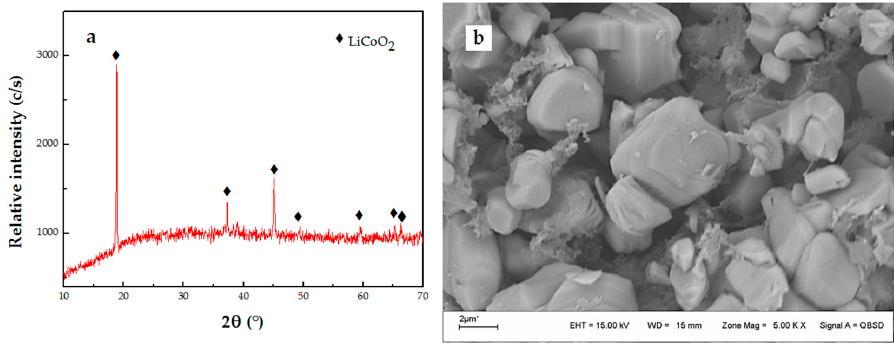
Figure 1. ( a ) XRD and ( b ) SEM of LiCoO 2 from cathodes of LIBs.